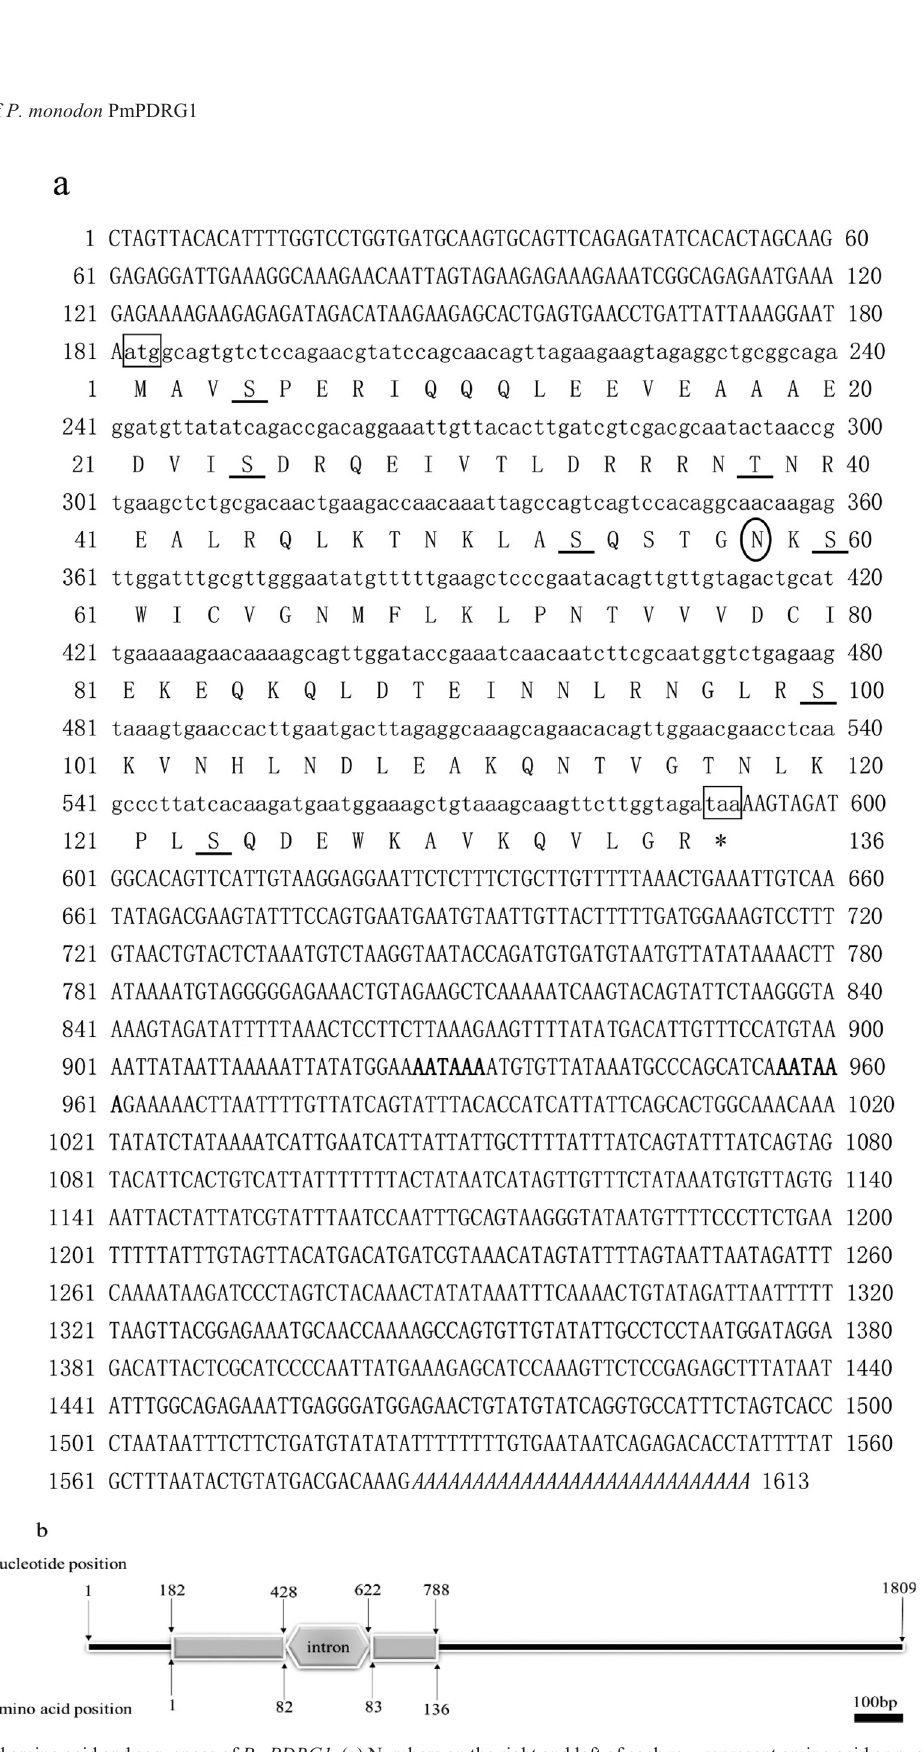
Figure 1 - Deduced amino acid and sequences of PmPDRG1 . (a) Numbers on the right and left of each row represent amino acid or nucleotide position; sequences in the boxes represent the start codon (ATG) and termination codon (TAA); eukaryotic polyadenylation signals AATAAA are highlighted in bold; the polyA signal sequence is italicized; the N-glycosylation site is marked by a circle; phosphorylation sites are underlined. (b) Schematic diagram representing the genomic DNA region of PmPDRG1